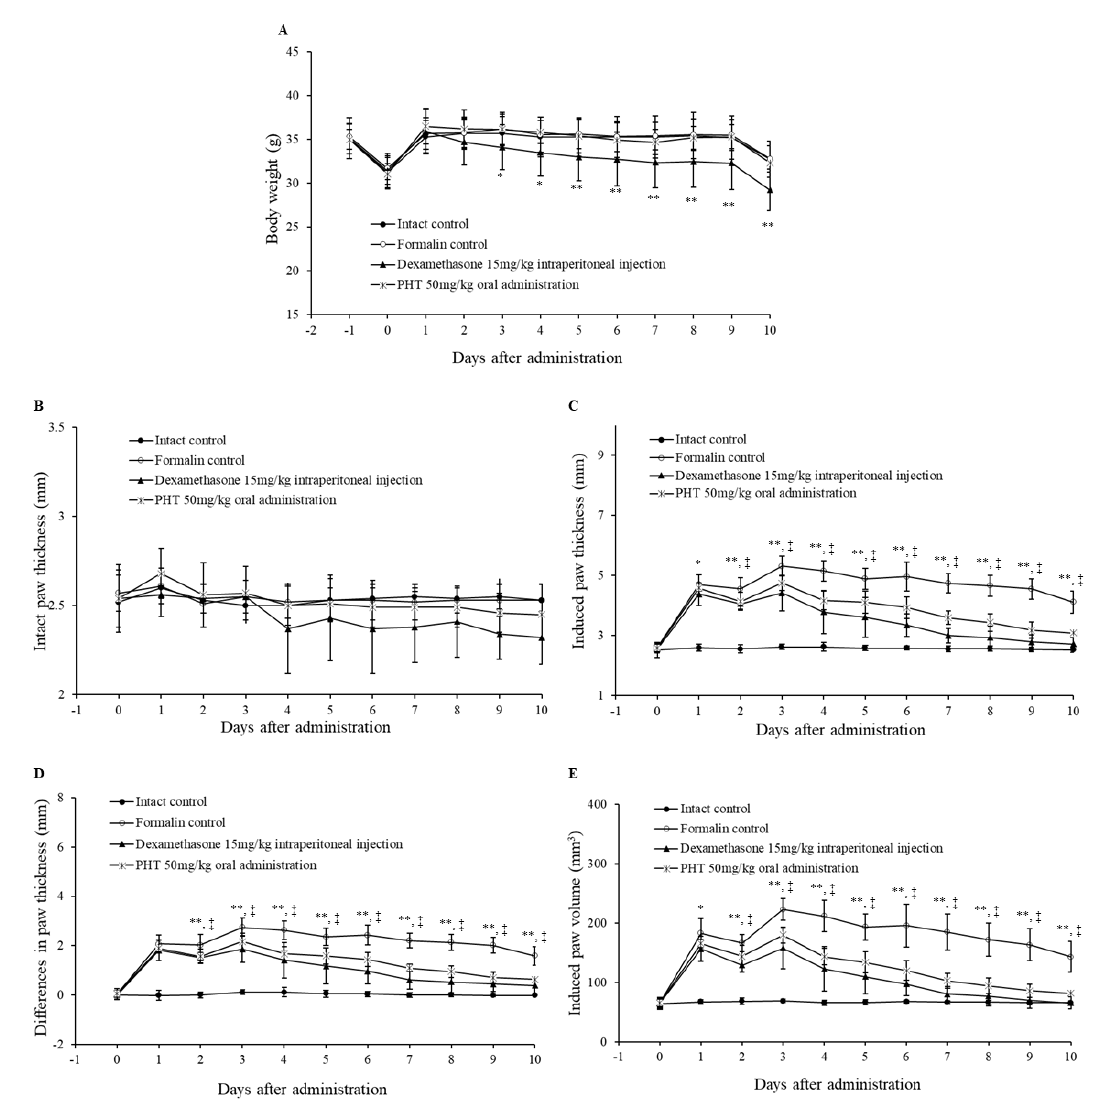
Figure 4. Changes in body weight, intact and induced paw thickness and induced paw volume. Six-week-old male ICR mice were intraperitoneally injected with saline or dexamethasone (15 mg / kg) or orally administered PHT (50 mg / kg) once a day for 10 days. Chronic inflammation was induced by subaponeurotic injection of 0.02 mL of 3.75% formalin into the left hind paw on the first and third days after administration. ( A ) Body weight, ( B ) intact paw thickness, ( C ) induced paw thickness, ( D ) di ff erences in paw thickness and ( E ) induced paw volume were measured. The p value of the dexamethasone-treated group is presented as * p < 0.05 and ** p < 0.01 compared with the formalin control group. The p value of the PHT-treated group is presented † p < 0.05 and ‡ p < 0.01 compared with the formalin control group. The values are presented as the mean ± SD of nine experimental animals.